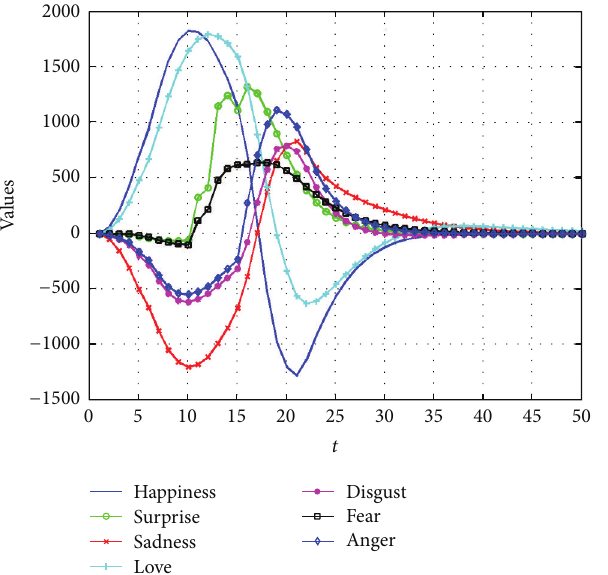
Figure 3: Graph of emotions generated by young males.